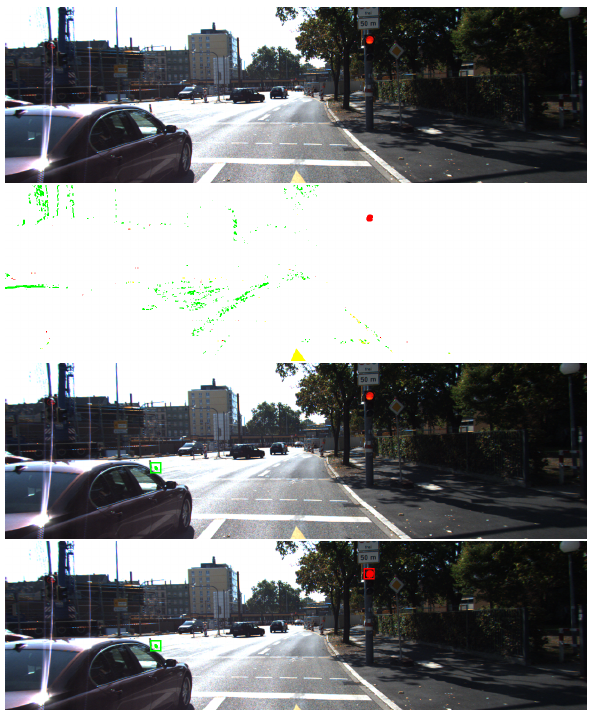
Figure 9: The traffic light detection algorithm using mono cam- era (third row) has a few false positives. The stereo cameras ap- proach (fourth row) does not contain any false positive while it it maintains the true positives.